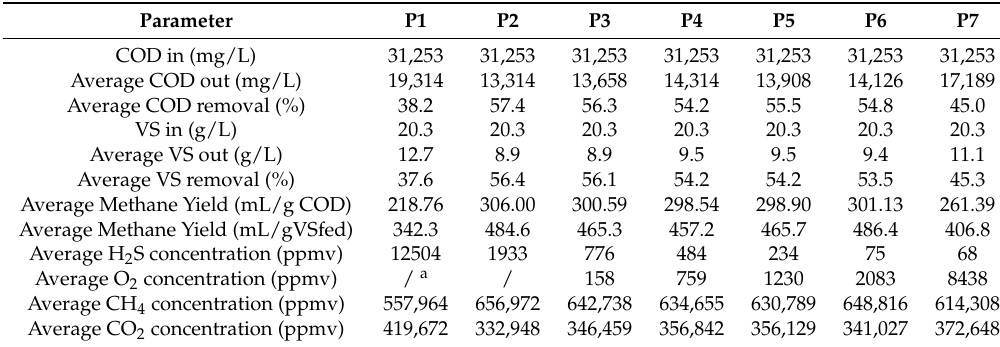
Table 3. Reactor performance during semi-continuous anaerobic and microaerobic digestion of activated sludge supplemented with RSI over seven periods of operation associated with stepwise increases in oxygen concentration.